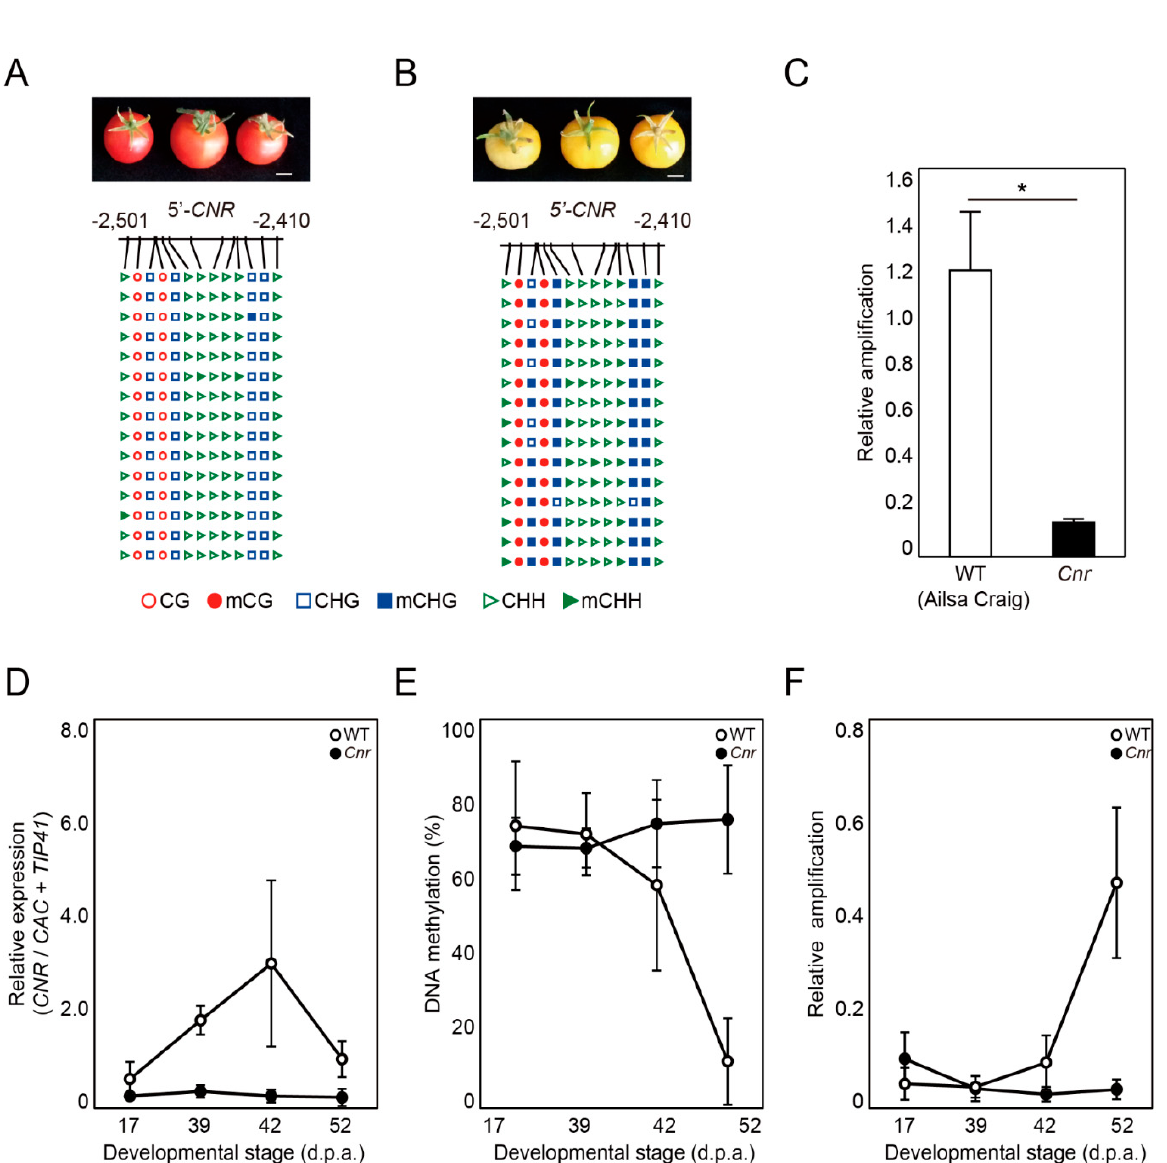
Figure 4. DME-qPCR for quantitative DNA methylation analysis for Cnr alleles during fruit ripening in tomato. ( A , B ) Mature fruit colors and DNA methylation profiles at 2.4–2.5 kb upstream of the translation start site of CNR gene in wild type Ailsa Craig ( A ) and Cnr mutant ( B ), respectively. DNA methylation profiles were analyzed by bisulfite sequencing. Genomic DNA isolated from individual plants was subjected to bisulfite sequencing analysis. Scale bar = 10 mm. ( C ) DME-qPCR analysis for CNR in wild type Ailsa Craig and Cnr mutant leaves. DME-qPCR amplification values were calculated relative to unmethylated ATP1 gene. Asterisks indicate statistically significant differences between WT and Cnr (*: p < 0.05; Student’s t -test). ( D ) Expression of CNR in wild-type and Cnr mutant tomato fruits during ripening. CNR expression was determined by RT-qPCR in fruit pericarp at 17, 39, 42, and 53 d.p.a. Expression levels were relative to combined expressions of CAC and TIP41 [26]. ( E ) DNA methylation levels of CNR in wild-type and Cnr mutant tomato fruits during ripening. DNA methylation levels at the DMR 0.7 kb upstream of the translation start site of Cnr gene were determined by bisulfite sequencing in pericarp tissues of wild type Ailsa Craig and Cnr mutant at 17, 39, 42, and 52 d.p.a. ( F ) DME-qPCR analysis for detection of DNA methylation changes at CNR during fruit ripening. Changes in DNA methylation level at the − 0.7 kb DMR of Cnr gene were examined by DME-qPCR. DME-qPCR amplification values were calculated relative to Actin (Solyc01g066800). The data represent the mean ± S.D. of three replicates ( C , D , F ).